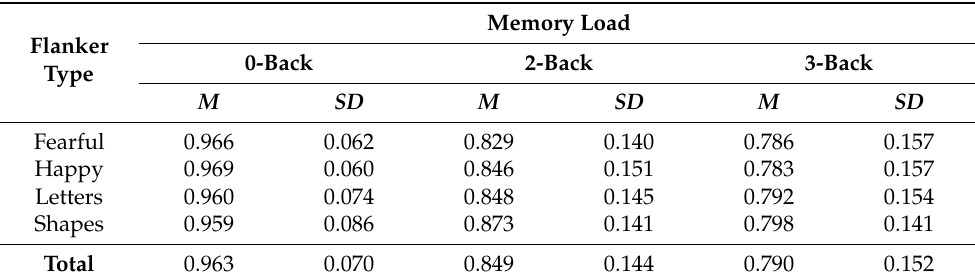
Table 2. Means and SDs of participants’ accuracy rates on the Emotional Flanker N-back (EFNB) task